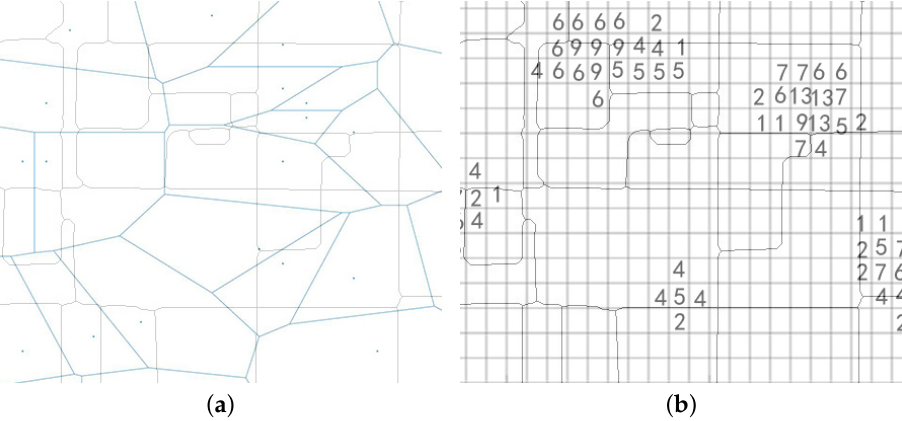
Figure 7. Core steps for mapping users from voronoi polygons to grid cells. ( a ) Map the users from base station to the street region; ( b ) Map the population from WorldPop to the street